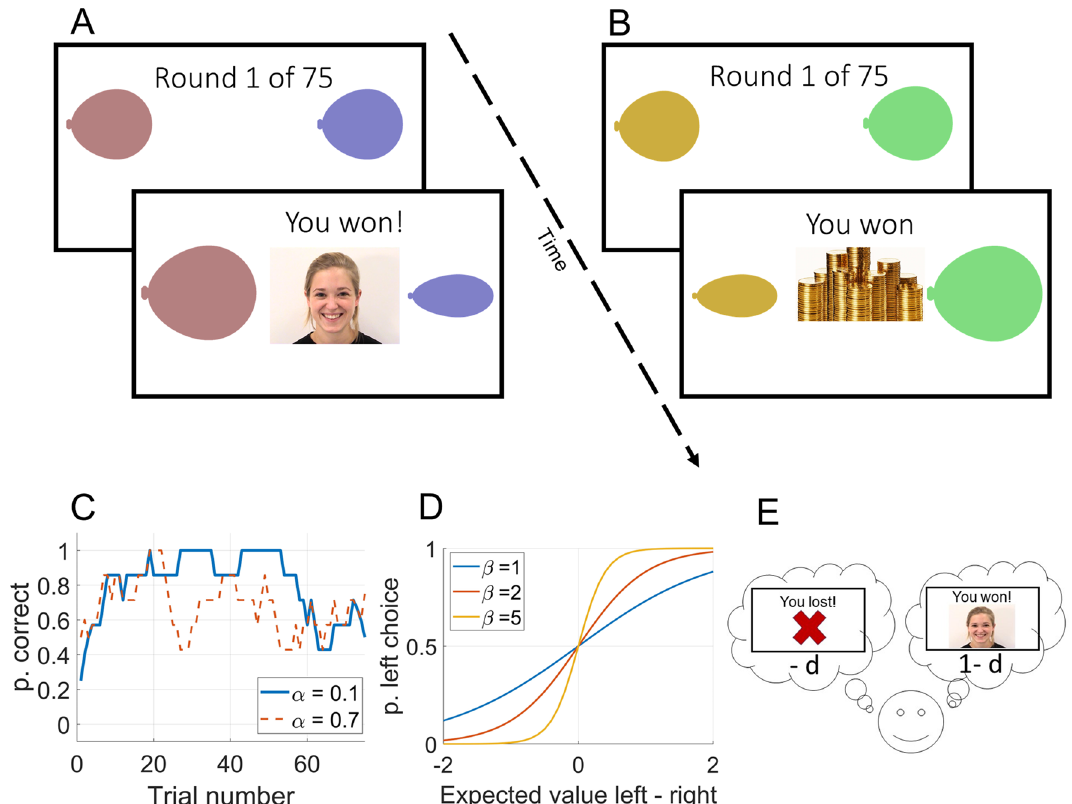
Figure 1. ( A , B ) Overview of the experiment. Participants completed the social ( A ) and the non-social feedback condition in counterbalanced order. Each round consisted of 75 trials. Participants were instructed to collect points by choosing between two balloons, and told that one of the options was better. In both conditions, the reward probabilities of the stimuli were 2/3 and 1/3 respectively. Stimulus color and position of the better stimulus (left/right) were counterbalanced between participants and conditions. After selecting one of the two stimuli, participants received either social feedback (an animation of a smiling model, A ), or non-social feedback (an animation of a pile of gold coins, B ). ( C–E ) Effects of different values of reinforcement learning parameters. ( C ) Higher values of α increases the degree of updating of action values after each outcome, leading to increased choice volatility. ( D ) Higher values of β (exploitation/exploration balance) leads to more deterministic choices, so that participants prefer the stimulus (left, right) with higher action value. ( D ) The parameter d (loss/reward weight) determines the degree the relative subjective value of losses as compared to wins, so that an agent with d > 0.5 gives higher weight to losses, an agent with d < 0.5 gives higher weight to wins, and d = 0.5 means that equal weight is given to both